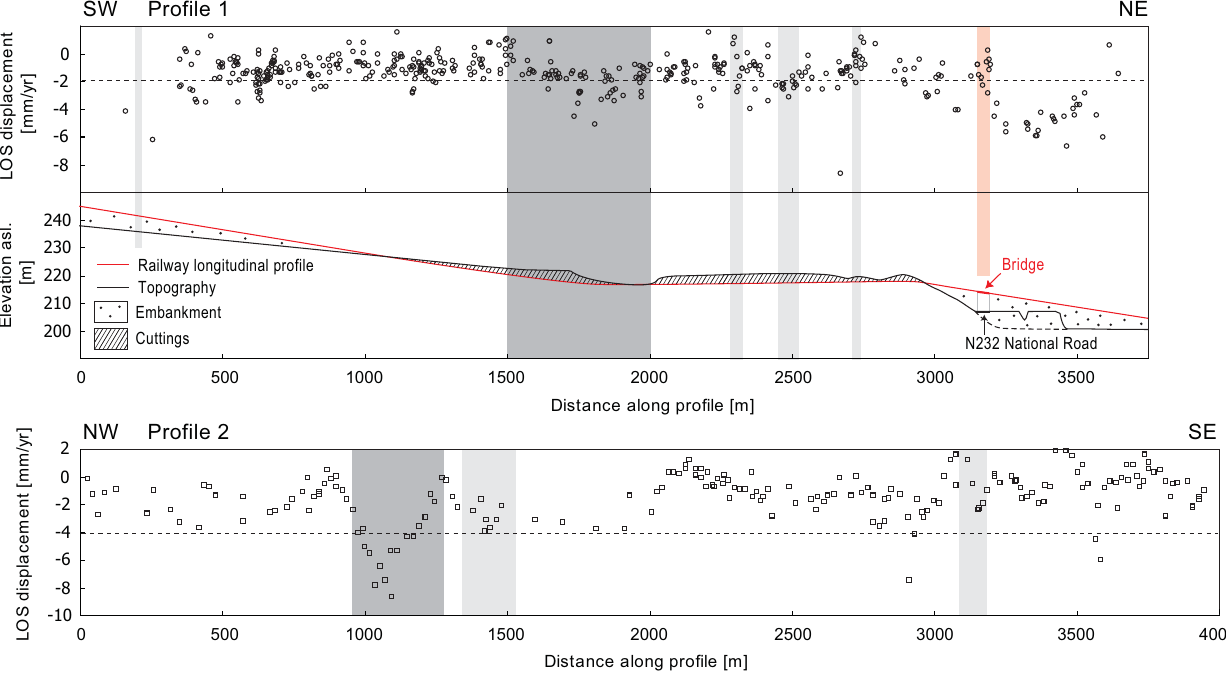
Figure 4. Profiles with DInSAR-derived LOS deformation data obtained along the analysed railway sections. Data from the Madrid– Barcelona railway corridor are represented alongside a topographic profile showing the stretches built on embankment and excavated trenches. Dark grey and light grey zones indicate sections built on sinkholes classified as being active and inactive, respectively. See lo- cation of profiles in Fig.